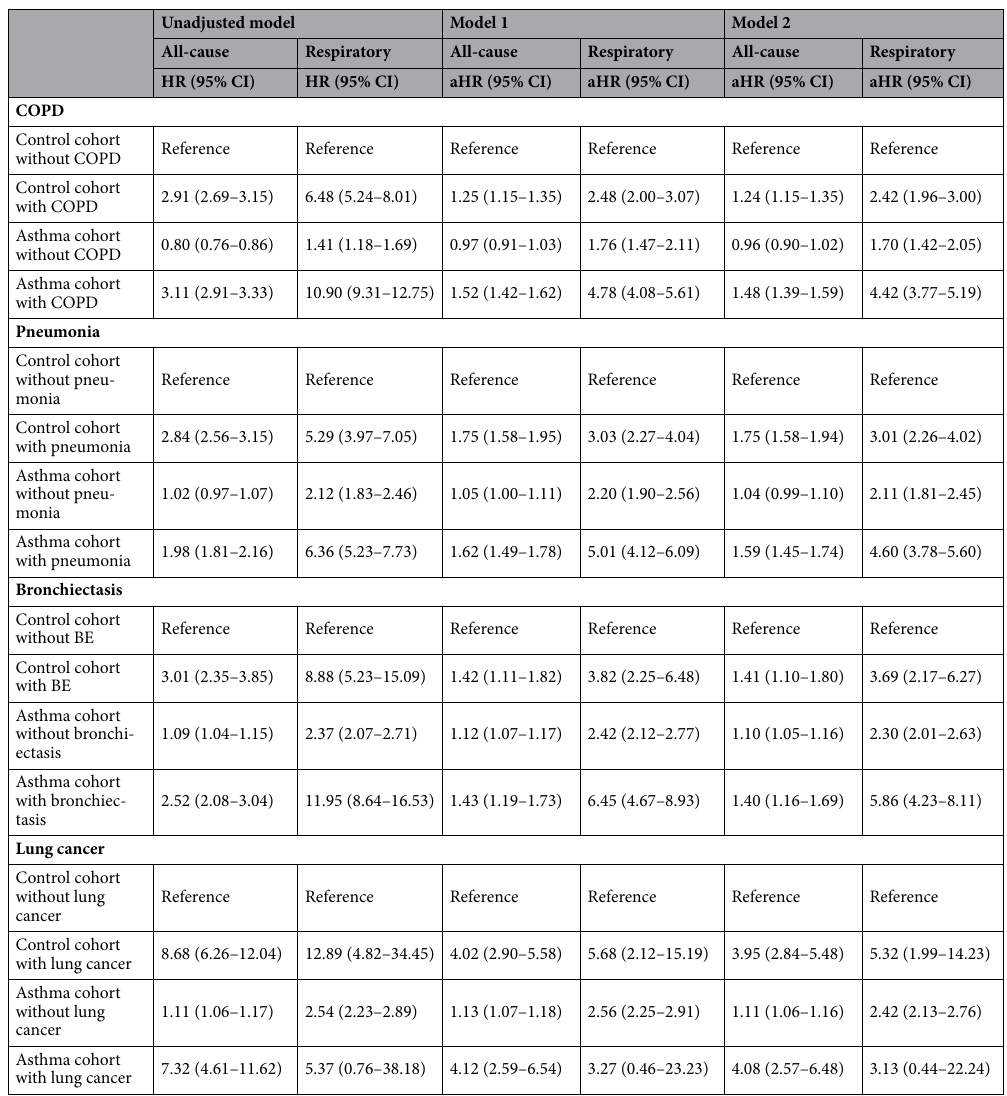
Table 3. The risk of mortality according to the presence of asthma and its coexisting respiratory comorbidities. Data are presented as a ratio (95% CI). Model 1: age and sex were adjusted; Model 2: age, sex, and type of insurance were adjusted. HR, hazard ratio; CI, confidence interval; aHR, adjusted HR; COPD, chronic obstructive pulmonary